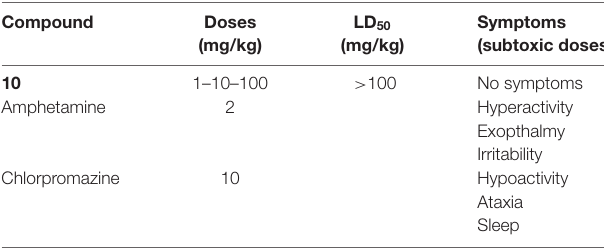
TABLE 4 | Pharmacological and toxicological properties of 10